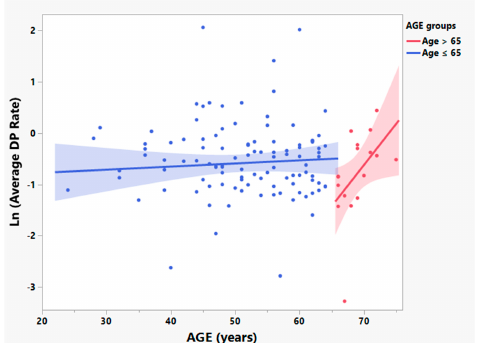
Figure 3. ALS patients aged > 65 years (depicted in red) showed baseline average rates of disease progression (Average DP Rate) different from those patients ≤ 65 years old in the phase 2A trial. Bivariate linear fit was used for the linear regression analysis, and showed a direct relationship between the log transformed DP rate (Average DP Rate) and age among participants > 65 years old (R 2 : 0.25, p = 0.04, n = 17, depicted in red). No linear association between age and Average DP Rate was found in those ≤ 65 years old (R 2 = 0.00, p = 0.51, n = 108, depicted in blue).